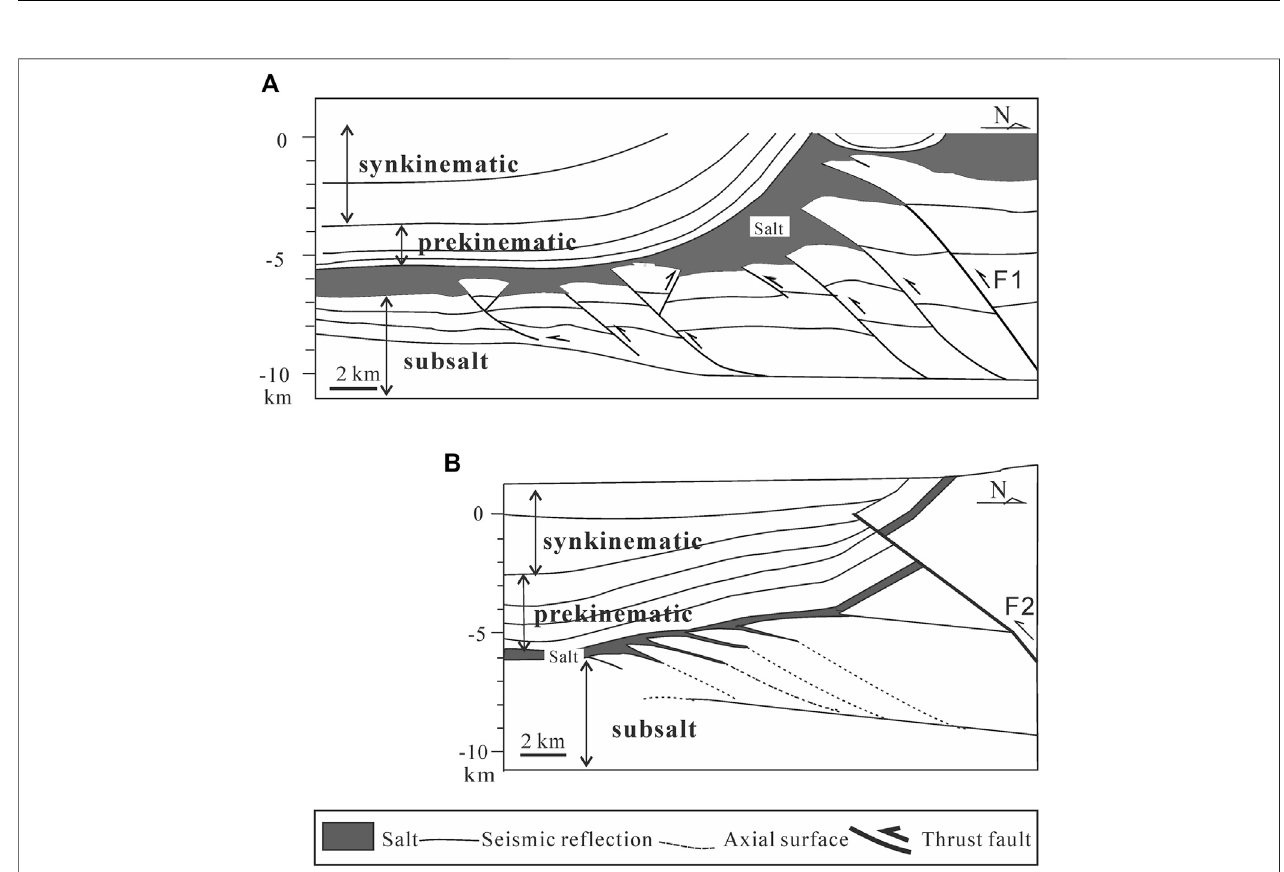
FIGURE 3 | Two interpreted models of seismic pro fi les in the northern margin of western Kuqa Depression. (A) The thick salt model. Interpreted seismic section Line 1 (see Figure 1 for location) of the western Kelasu structure in the western Kuqa Depression; data revised from Wang et al. (2017). (B) The thin salt model. Interpreted seismic section Line 2 (see Figure 1 for location) of the eastern Kelasu structure in the western Kuqa Depression; data revised from Wu et al. (2014). The prekinematic strata (syn, isopachous layer) interval whose initial stratigraphic thickness is constant above a salt structure. It records sedimentation before salt movement. The synkinematic layer accumulated during salt fl ow and may include internal onlap or truncation. The subsalt strata were sedimentary units immediately underlying salt.